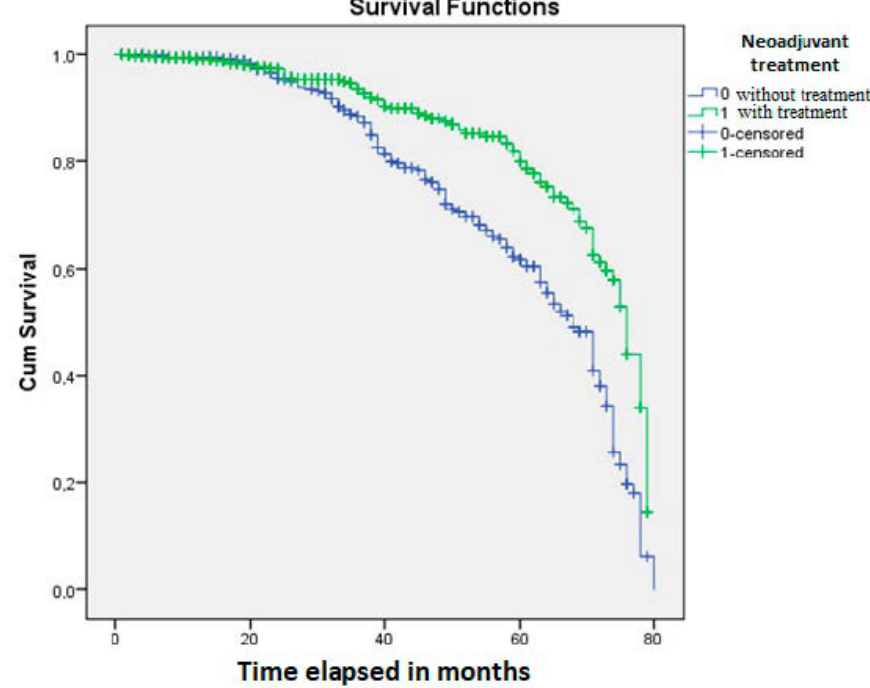
Figure 2. Neoadjuvant treatment significantly influences patients’ survival rate, compared to those who did not receive preoperative oncotherapy ( p = 0.0001).